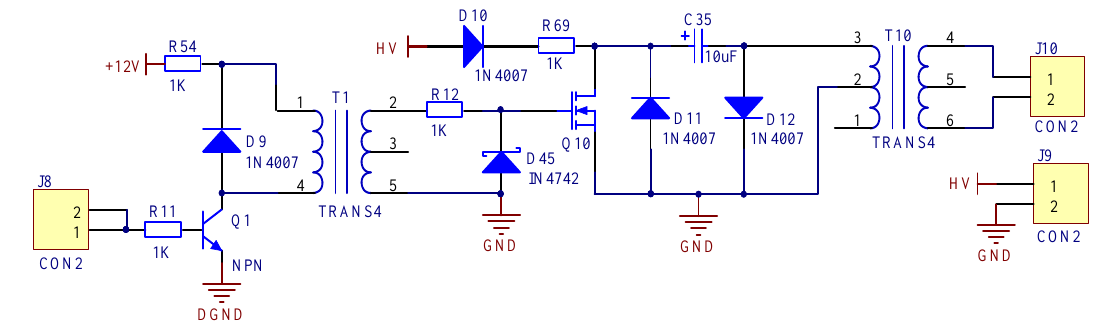
Figure 6. The schematics of the driver circuit.